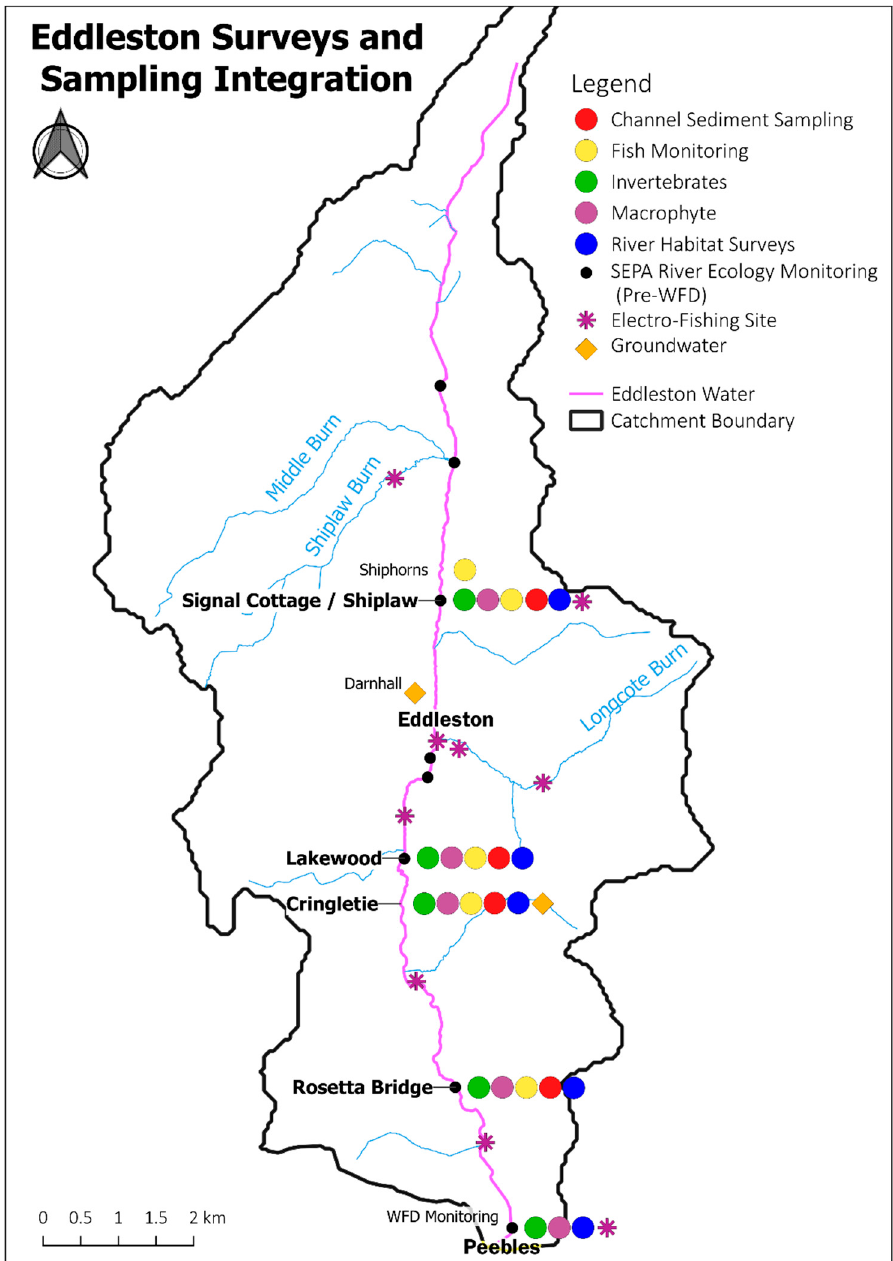
Figure 4. Eddleston Water integration of catchment restoration monitoring networks.